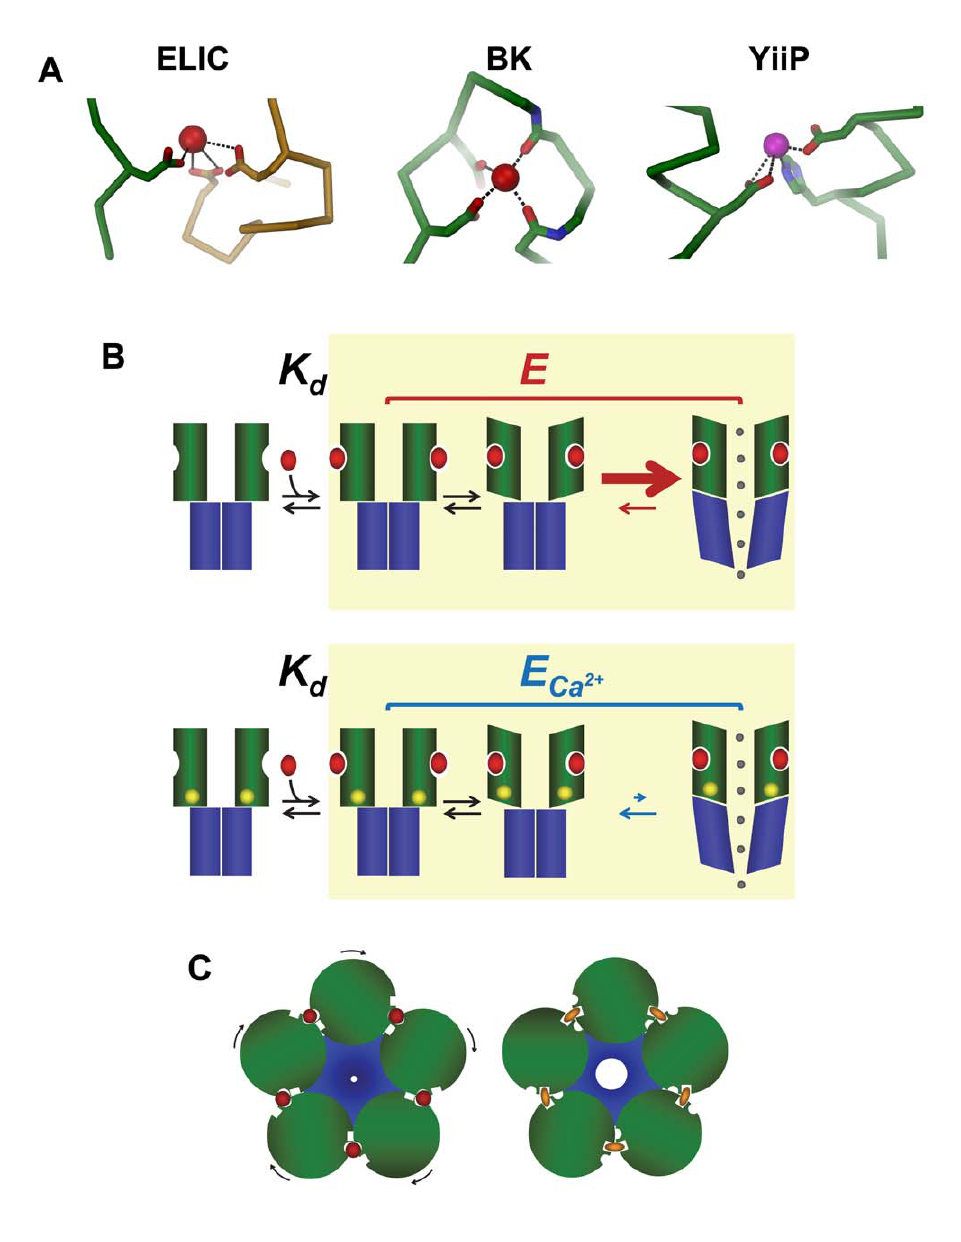
Figure 7. Potential mechanisms. (A) Interactions in the regulatory divalent ion-binding site of ELIC (left) in comparison with a regulatory Ca 2 + binding site of the BK-channel (middle) and the Zn 2 + -transporter YiiP (right). (B) Schematic model of a potential mechanism for the inhibitory effect of divalent ions. The two rows show simplified schemes for channel activation in control conditions (top) and in the presence of divalent ions. From left to right, the schemes show that binding of agonist molecules (red ovals) to the extracellular domain (with microscopic affinity K d ) is followed by conformational changes (yellow background) that result in channel opening. Channel gating (described by the efficacy equilibrium constant E ) is impaired when the channel is bound to divalent ions (yellow circles, E Ca2 + ). The decrease in agonist efficacy is likely to be due to a change in the rate of opening, as shown by the size of the arrows in the last step of the reaction. (C) Schematic mechanism of how binding sites located on similar places of an oligomeric channel could alternately stabilize the closed or open conformation of the